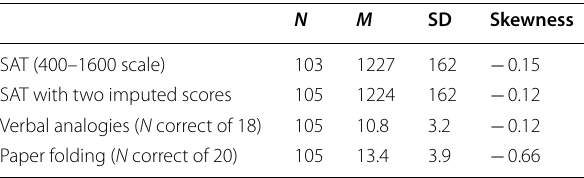
Table 6 Descriptive statistics for individual